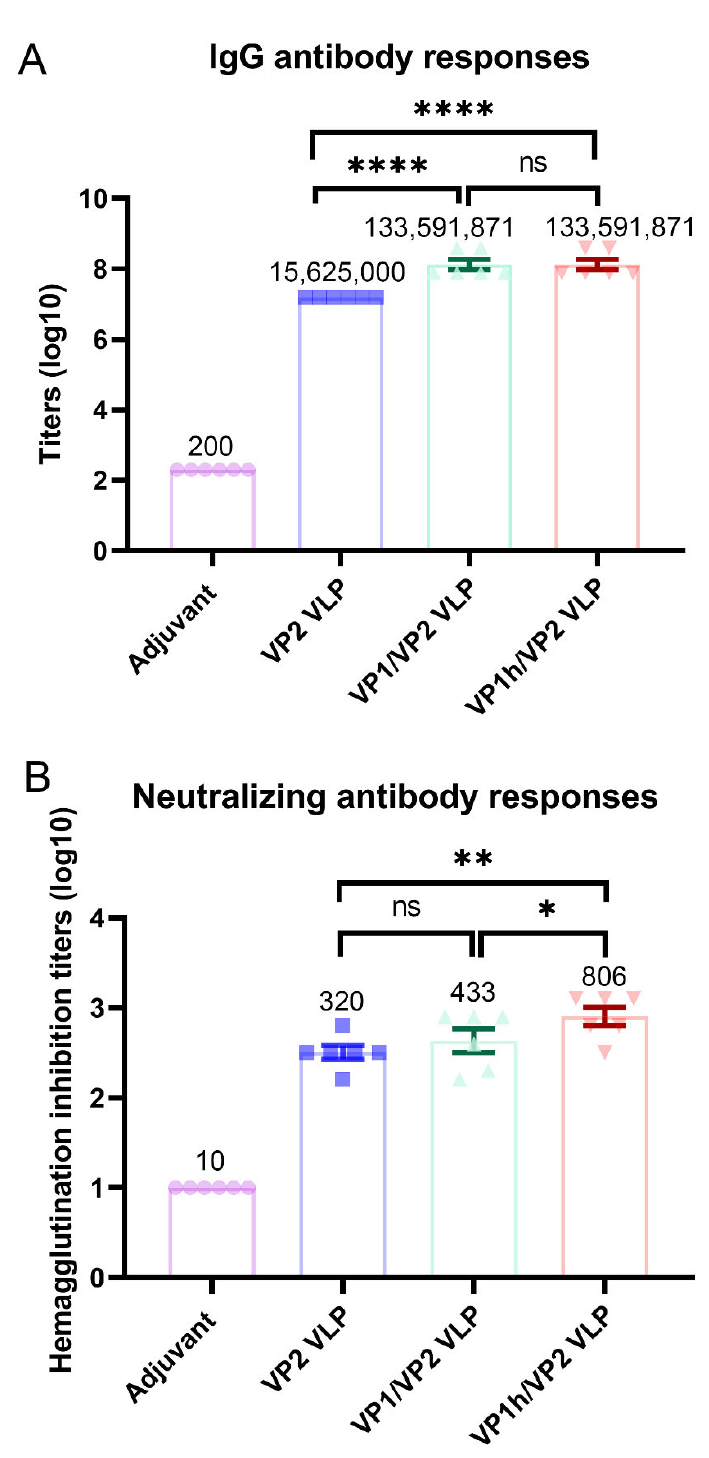
Figure 5. Immune responses induced by the recombinant VP1/VP2 and VP1h/VP2 VLPs compared with that induced by the VP2 VLP. ( A ): IgG antibody levels evaluated by enzyme linked immuno ‐ sorbent assay. ( B ): Neutralizing antibody levels evaluated by hemagglutination inhibition assay. Data are presented as mean ± SEM. GMT values are given on the top of each bar of the histogram. One ‐ way ANOVA followed by the LSD t ‐ test was applied to detect statistical difference between groups. * p < 0.05, ** p < 0.01, **** p < 0.0001, ns: not significant.